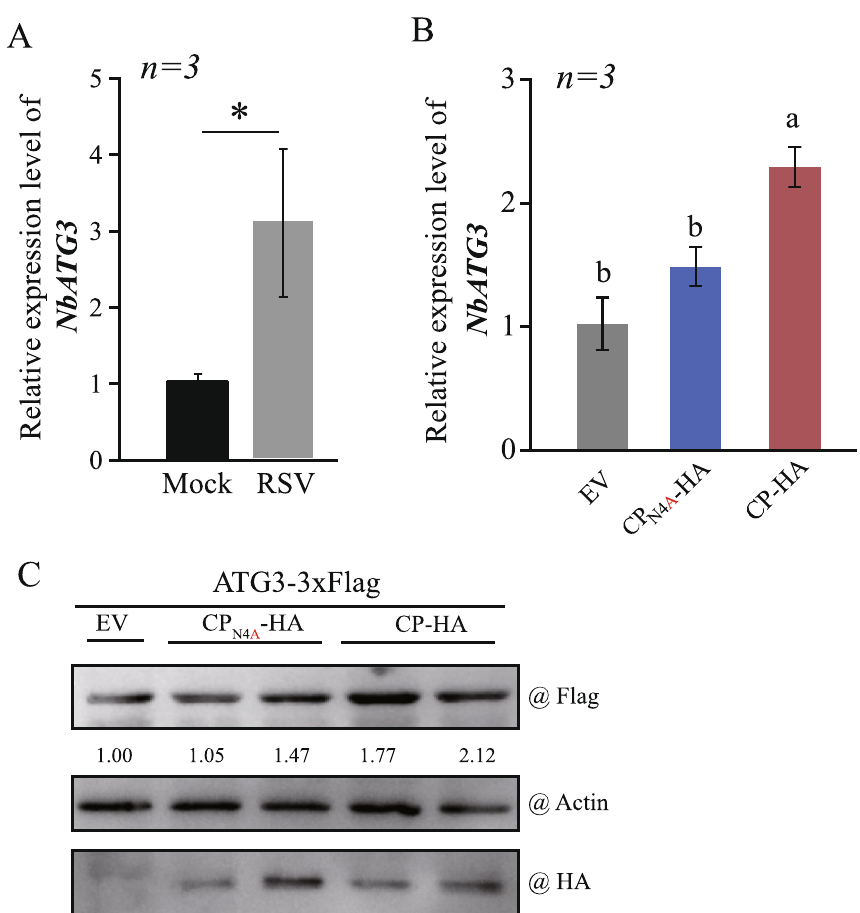
Fig. 6 The expression of the NbATG3 is upregulated by RSV or RSV CP. A and B RT-qPCR showed the upregulation of NbATG3 in RSV infection (A) or transiently expressed CP and CP N4A -HA(B) in N. benthamiana. The error bars represent the mean from three biological replicates. “*” indicates P < 0.05 (Student’s t -test) (A). Different letters above the bars indicate significant differences ( P < 0.05, one-way ANOVA) (B). C NbATG3-3XFlag was co-expressed with CP-HA and CP N4A -HA, and its expression was examined by western blot with an anti-Flag antibody. The accumulation of NbATG3-3XFlag protein was quantified by ImageJ and normalized to actin. The number indicates the relative NbATG3-3XFlag accumulation compared to the control sample (EV), which was set to 1.00. C The results are representative of three independent experiments